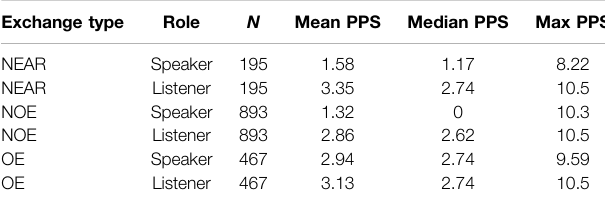
TABLE 3 | Turn Approach Brow PPS summary statistics (pooled over participants). Exchange type